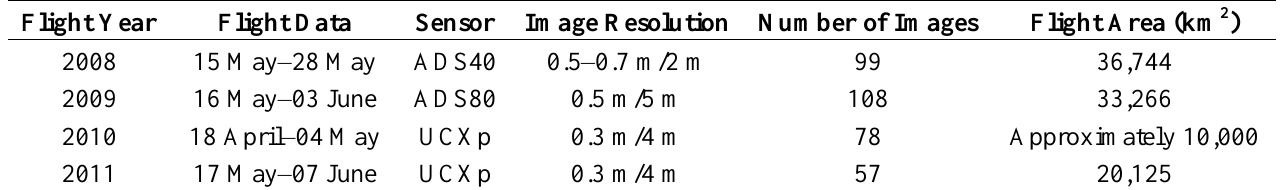
Table 1. Remote sensing data acquired over the earthquake-damaged